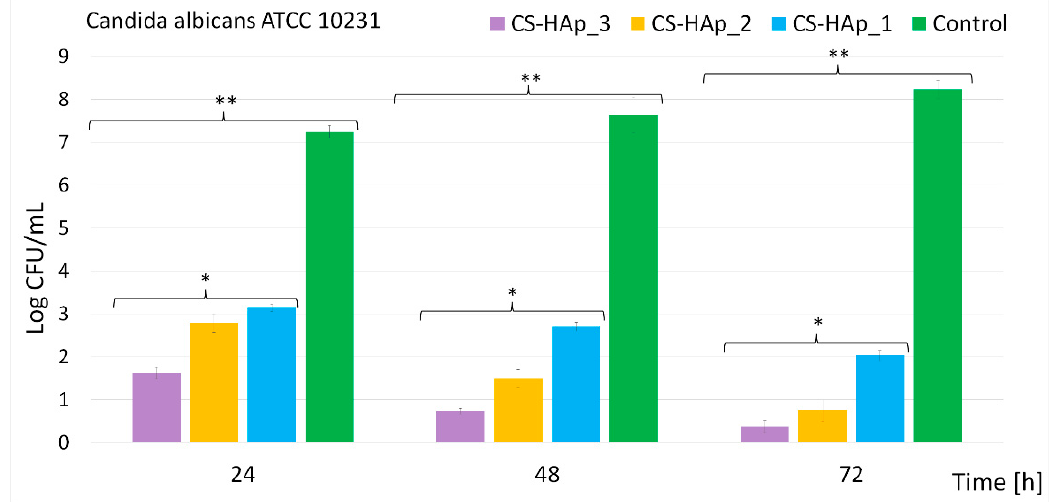
Figure 11. Antimicrobial activity of CS–HAp layers against Candida albicans ATCC 10231 at different time intervals. The results are presented as mean ± SD. Statistical analysis was performed by one-way ANOVA. The p -values indicated are the following: * p ≤ 0.003, ** p ≤ 0.0001.